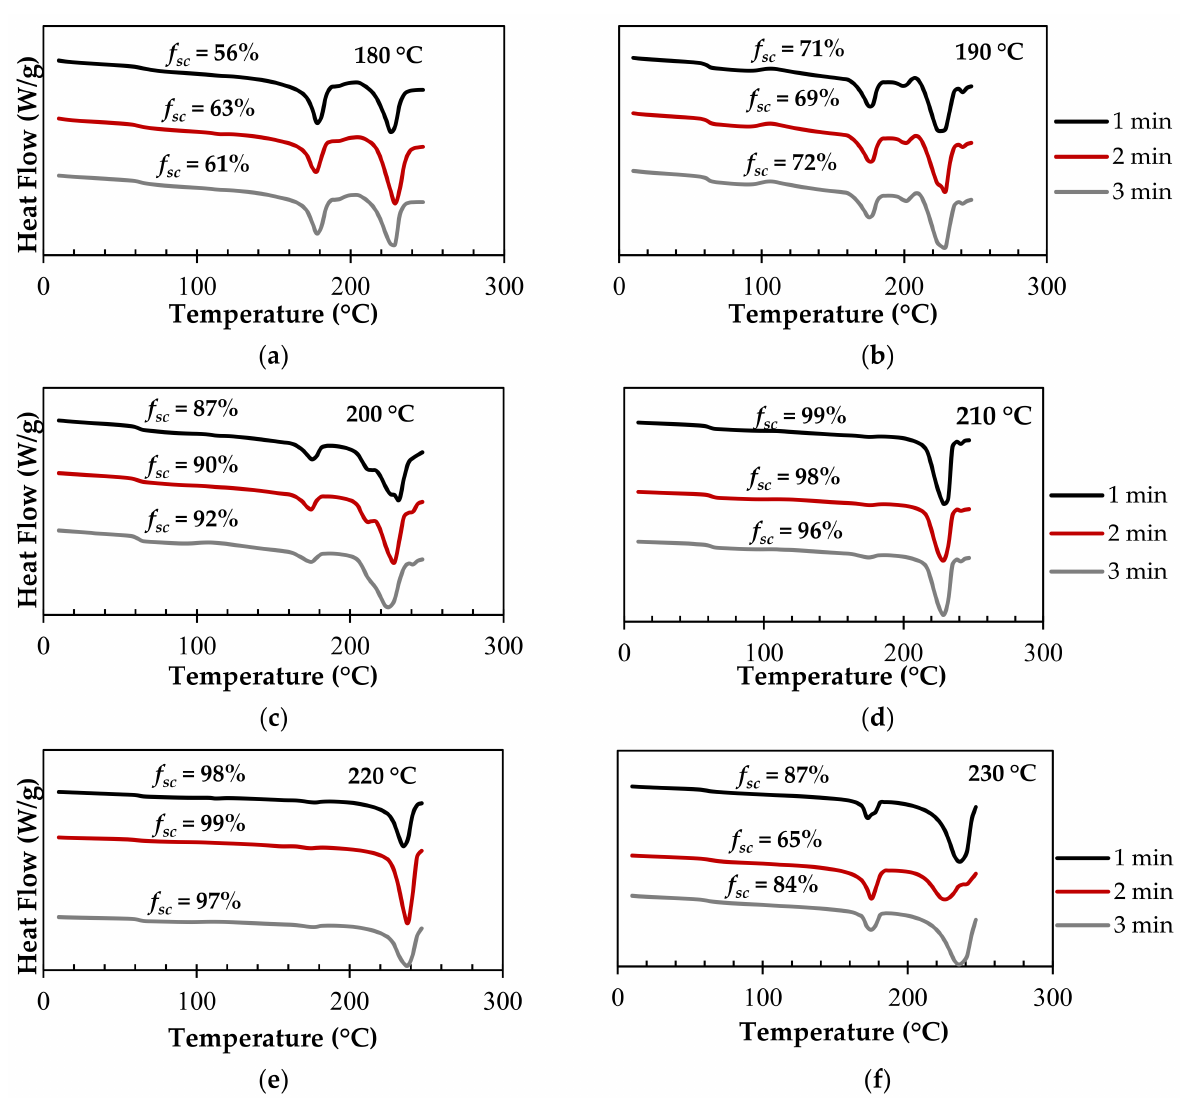
Figure 6. The DSC thermograms displaying stereocomplex formation after the sample was held isothermally for 1–3 min at temperatures of ( a ) 180 ◦ C, ( b ) 190 ◦ C, ( c ) 200 ◦ C, ( d ) 210 ◦ C, ( e ) 220 ◦ C, ( f ) 230 ◦